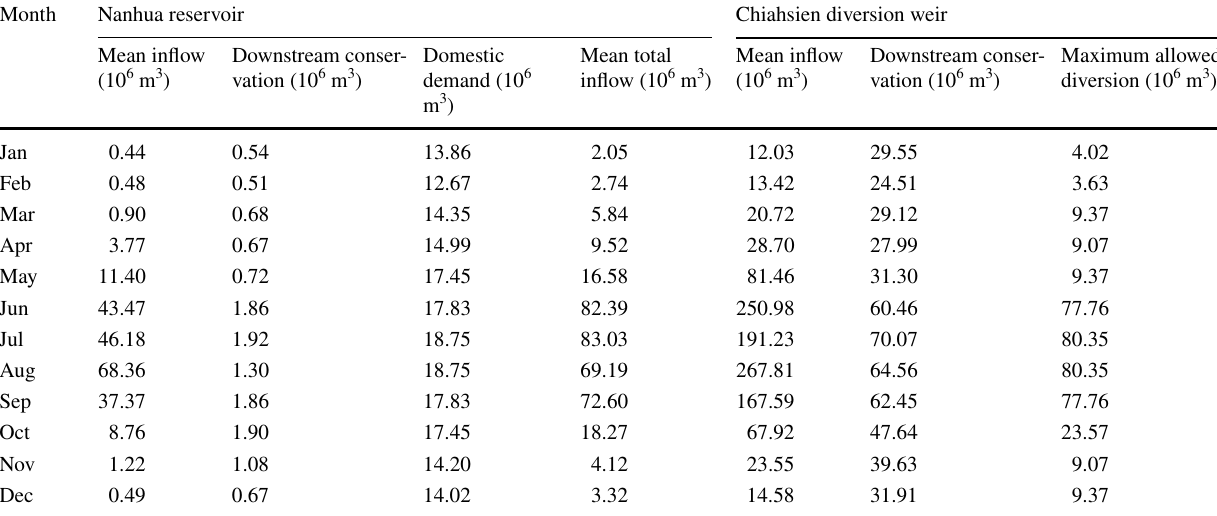
Table 1 Monthly mean inflow, projected domestic demand, reserved downstream needs, and the maximum allowed interbasin diversion for Nan- hua Reservoir and Chiahsien diversion